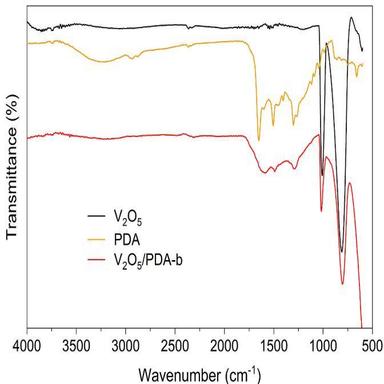
FTIR-ATR spectra of V2O5, polydopamine, and V2O5/PDA synthesized.